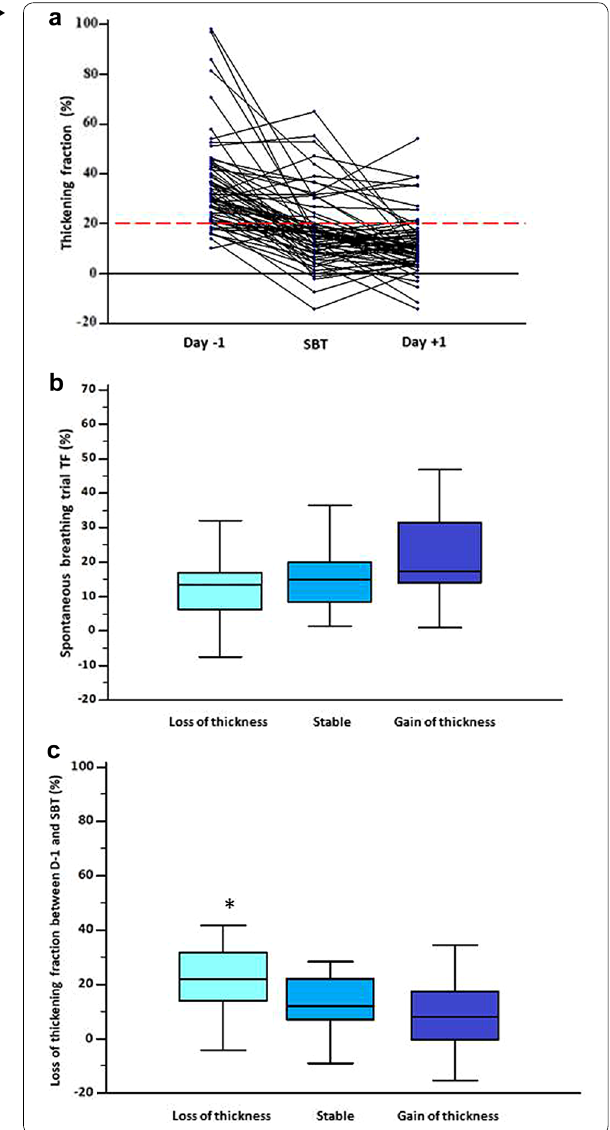
Fig. 3 Evolution of diaphragm thickening fraction and its impact on thickness. a Individual values of perioperative ultrasound measurement of diaphragm thickening. Diaphragm function was assessed by calculation of right diaphragm thickening fraction (TF). A TF below 20% during SBT (black dashed line) defined low diaphragm thickening during. In this study, 66 patients had